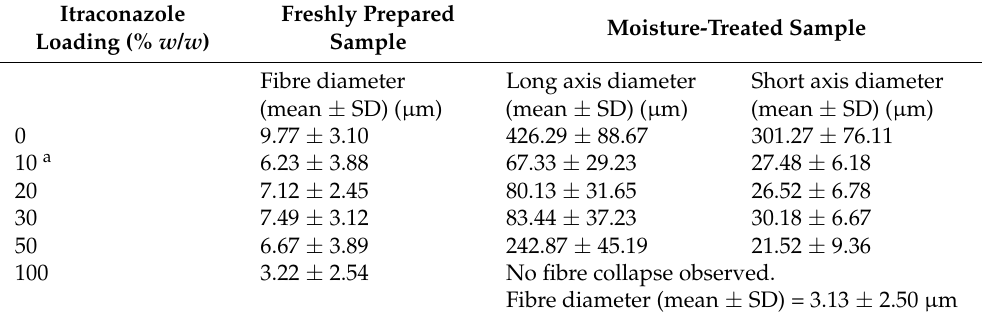
Table 2. Average microfibre diameter of freshly prepared samples and particle size (short and long diameter lengths) of the corresponding aged samples after 24 h storage (for microfibres containing 0 and 10% w / w itraconazole) and 30 days storage (for microfibres containing 20, 30, 50, and 100% w / w itraconazole) at 25 ◦ C/75%